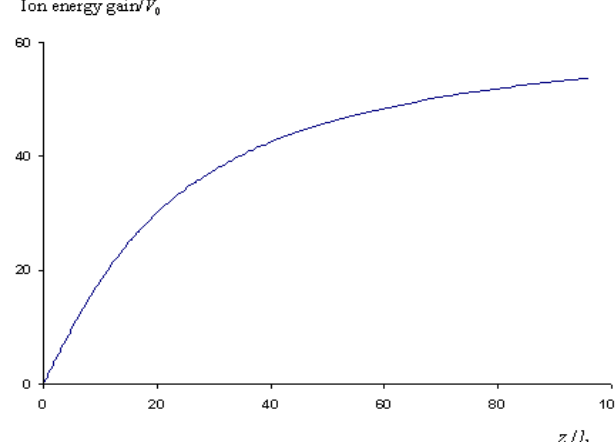
FIG. 12. (Color) Maximum ion energy gain in an untapered line vs system length normalized to l normalized to V 0 100 V 0